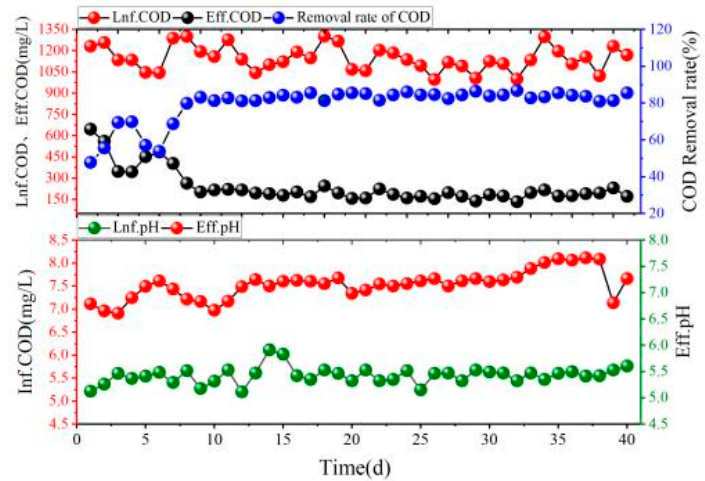
Figure 7. CMBR reactor operating parameters.